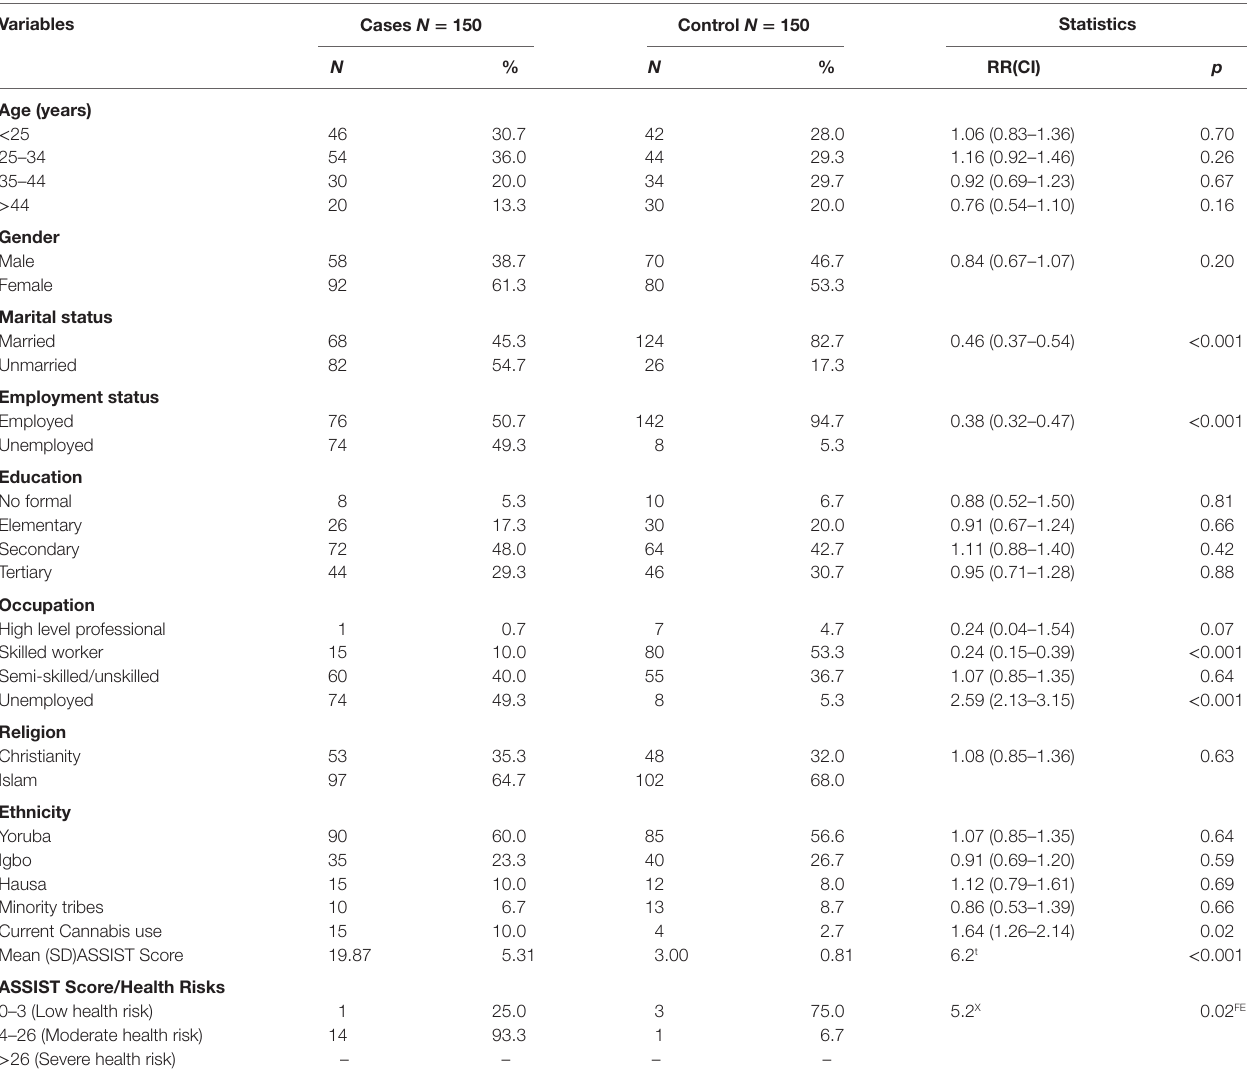
TaBle 1 | sociodemographic characteristics of